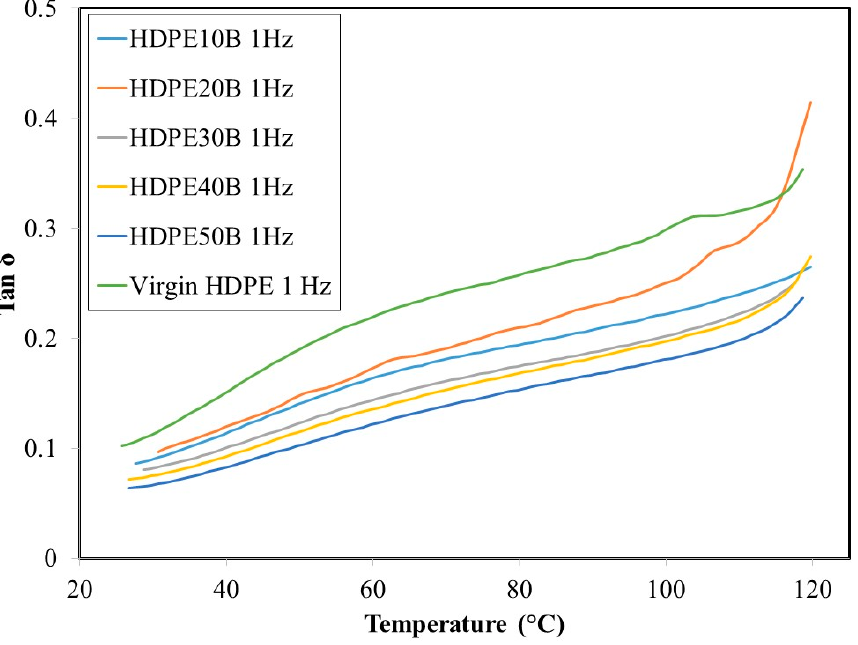
Figure 9. Loss modulus of HDPE/birch fiber composites at 20 Hz.